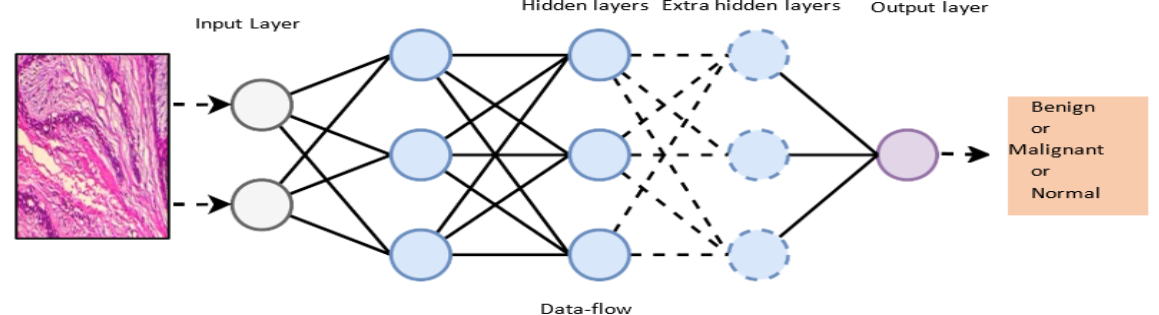
Figure 5. An illustration of the MLP.